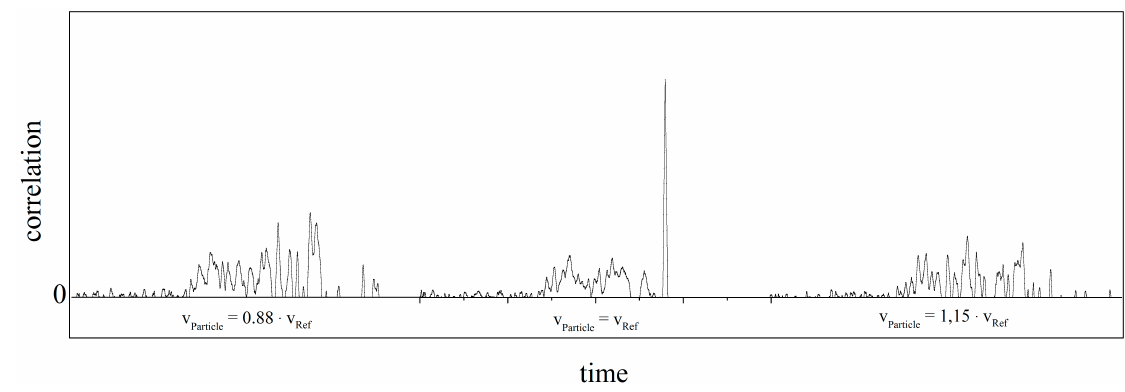
Figure 3. Signature of a fluorescently stained SUP-B15 cell traversing the mask. It takes ~2 ms for the cell to pass the mask length of 980 µm which corresponds to a velocity of 490 mm/s.